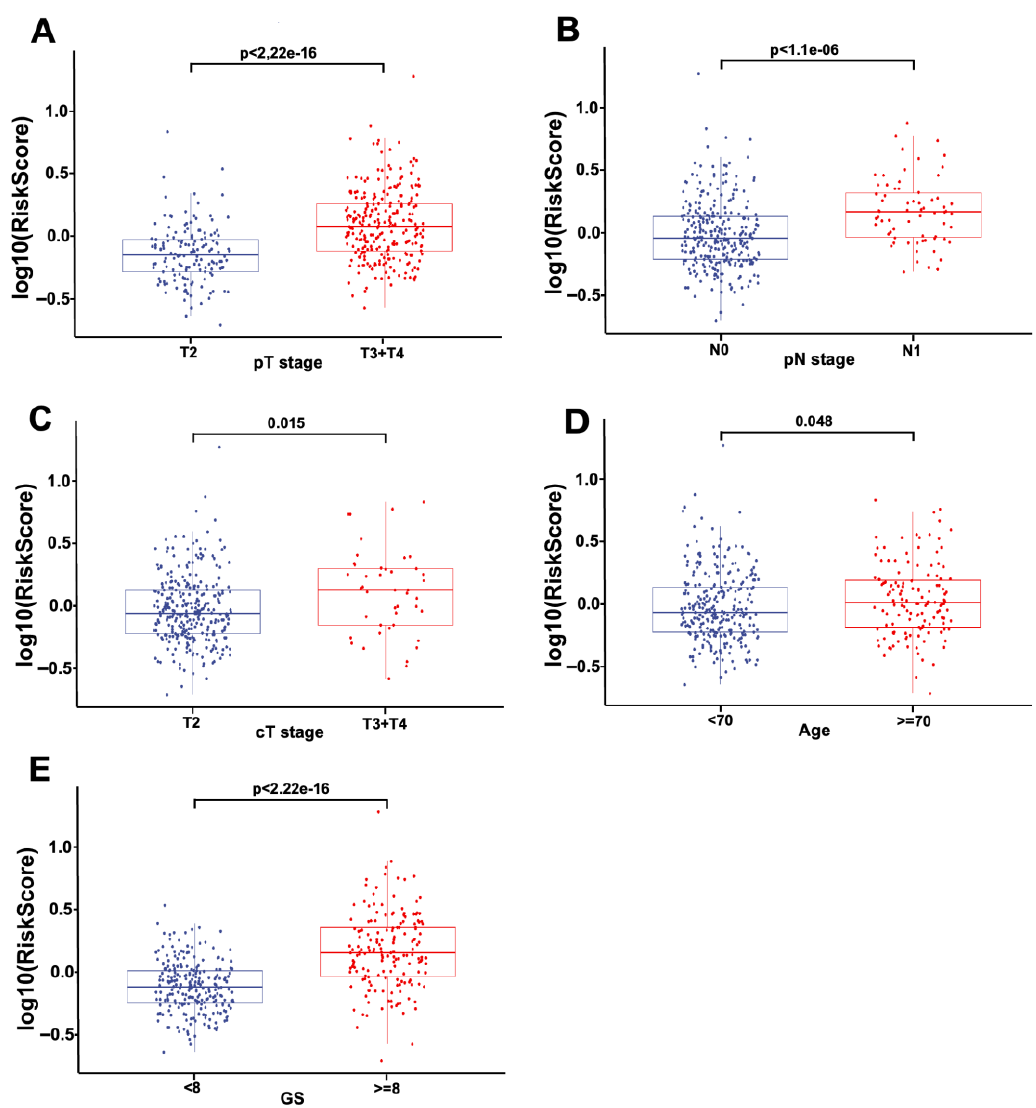
Figure 6. The association between the GS-based four-gene signature and clinical characteristics of PCa patients. The distribution of risk scores was associated with pathologic T ( A ), clinical T ( B ), pathologic N ( C ), Gleason score ( D ), and age ( E ).